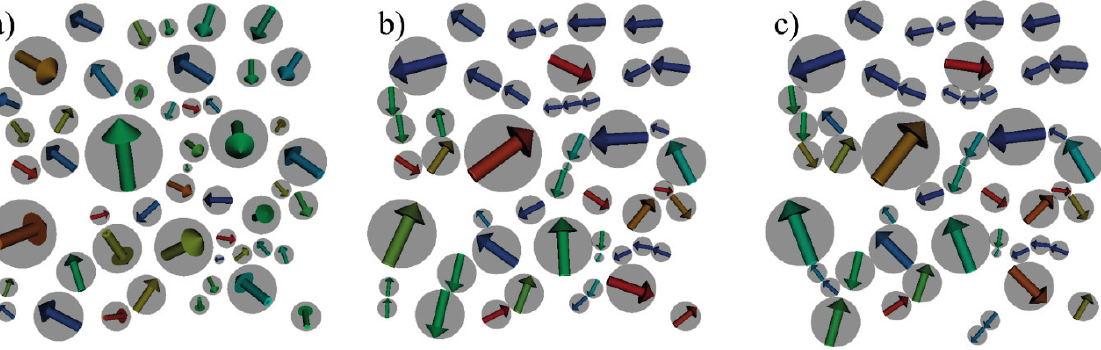
Figure 6. Results of a hybrid SD-MD simulation run of the model structure shown in Figure 5 in zero external magnetic field. The magnetic particles are shown in grey whereas the effective magnetic moments of the particles are represented by colored arrows. The colors of the arrows represent the horizontal, in-plane component of the magnetic moment. Starting from a random initial magnetic configuration with coplanar particle positions and random three-dimensional effective magnetic moment orientations ( a ), a stable final structure is reached after 3 × 10 7 hybrid SD-MD time steps ( c ). An intermediate configuration after 3 × 10 6 steps in time is shown in ( b ).